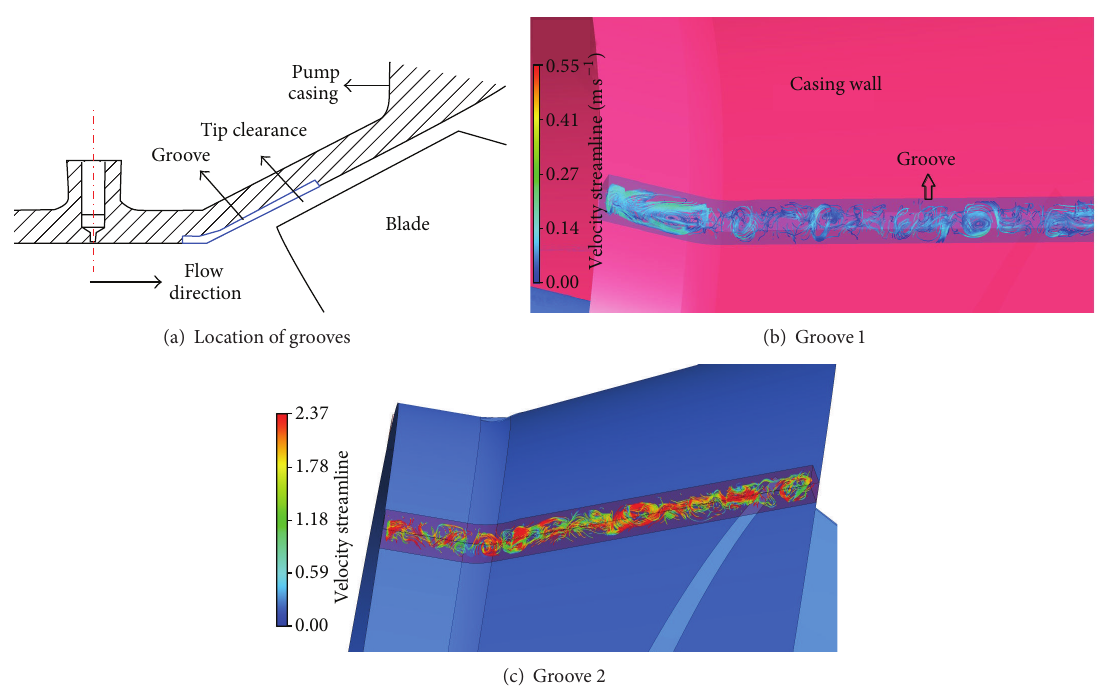
Figure 12: Velocity streamlines in the shallow groove (0.75 𝑄